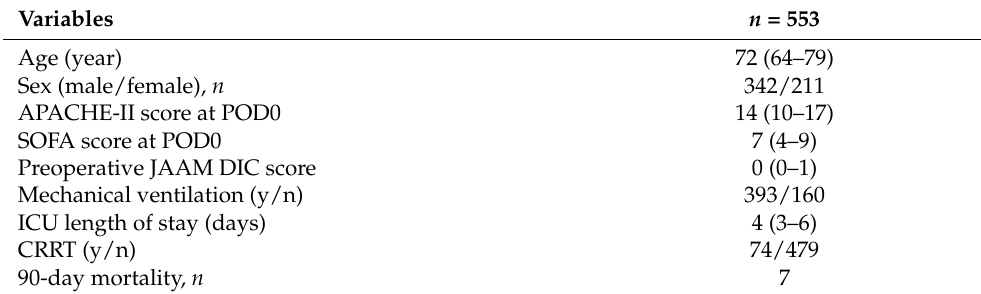
Figure 1. Schematic of patient recruitment. IABP: intra-aortic balloon pumping, V-A ECMO: venous- arterial extracorporeal membrane oxygenation, LVAD: Left ventricular assist device. Table 2. Baseline characteristics.